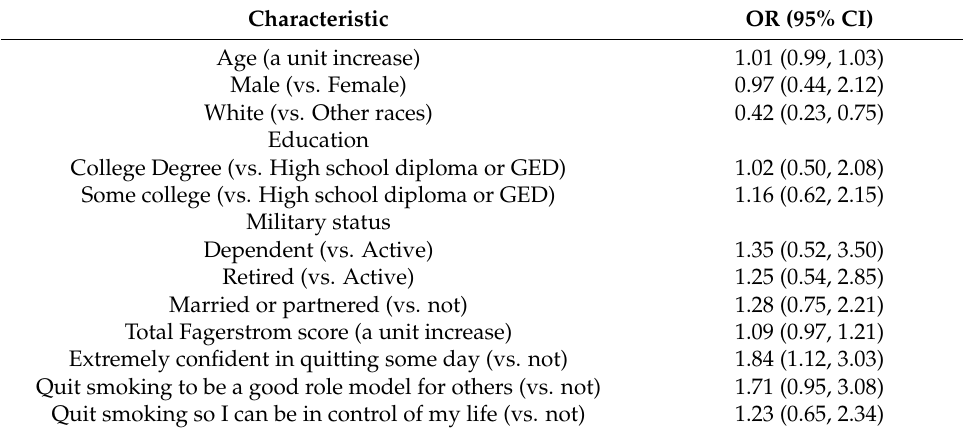
Primary Results: Multivariable results indicated that race, baseline confidence in quitting, and initial counseling sessions completed were associated with re-engagement (Table 3). Specifically, compared to non-White participants, White participants had lower odds of re-engaging (OR: 0.42, 95% CI: 0.23, 0.75). Participants who had the highest levels of confidence at baseline had 1.84 the odds of re-engaging compared to participants with lower levels of baseline confidence in quitting (95% CI: 1.12, 3.03). Participants who did not complete all the initial counseling sessions had lower odds of re-engaging at three months. NRT use during the initial intervention was not associated with re-engagement (OR: 1.55, 95% CI: 0.80, 3.02). Specific reasons to quit smoking were not associated with re-engagement in the final model. Table 3. Association between personal characteristics, and initial intervention engagement with re-engagement at three